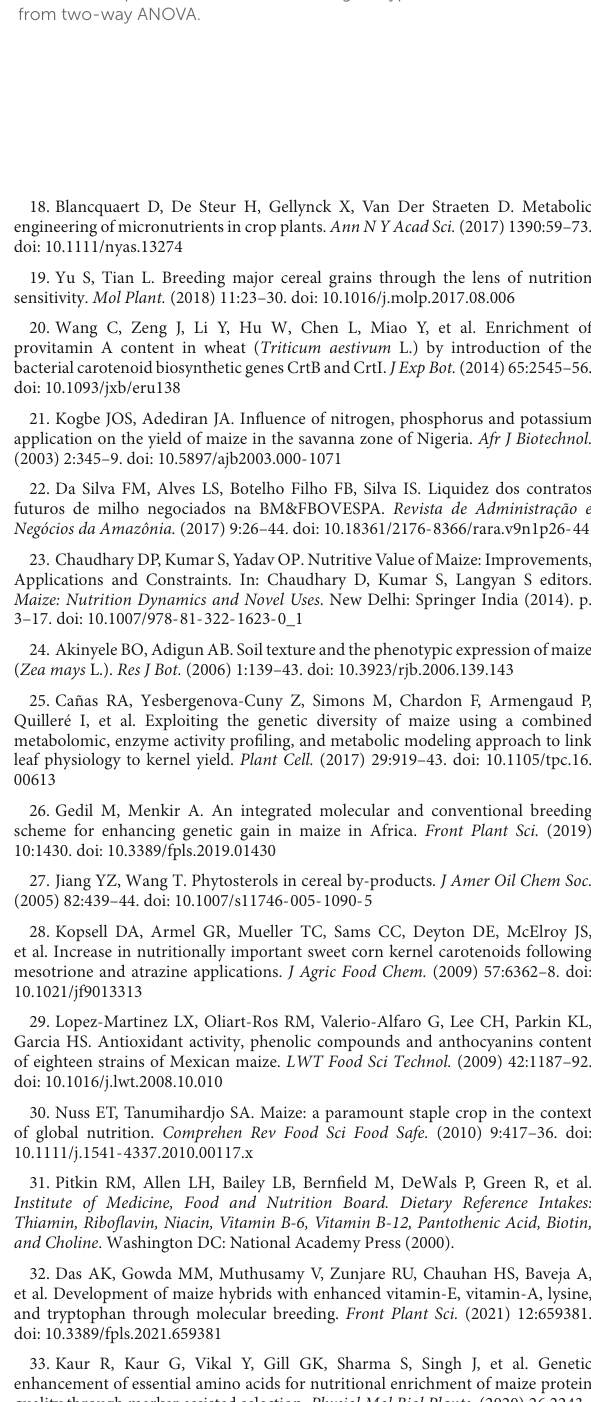
SUPPLEMENTARYTABLE4 Pairwise comparison for vitamins across genotypes from two-way